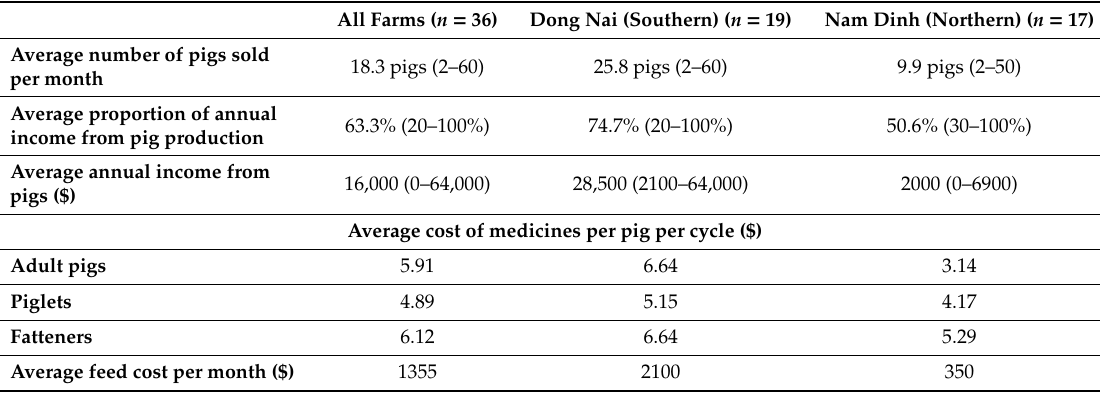
Table 3. Pig production and farm income data (min and max in brackets) (USD)